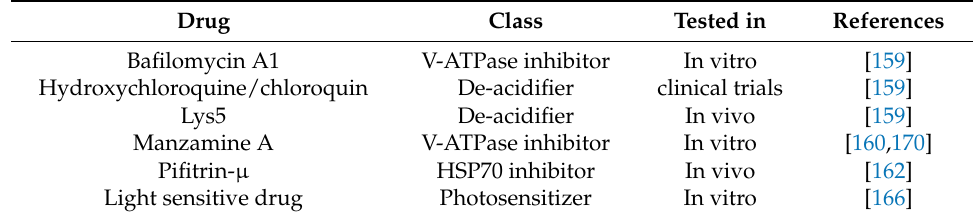
Table 3. Overview of candidate anti-lysosomal